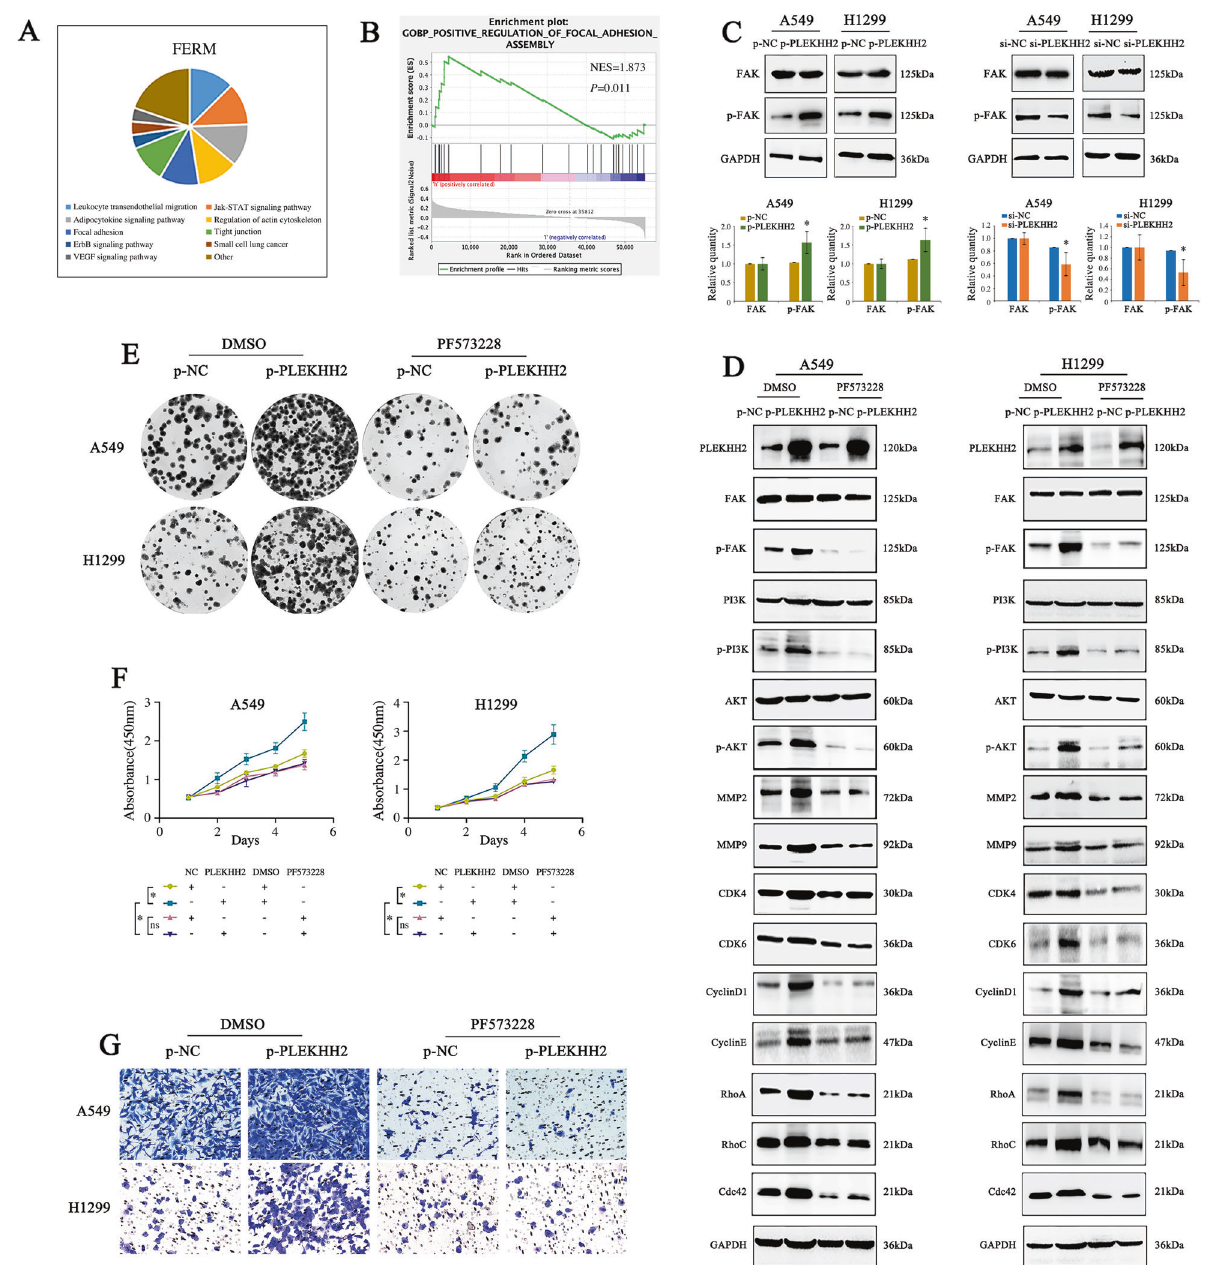
Fig. 5 PLEKHH2 activates the PI3K/AKT signaling pathway by promoting FAK phosphorylation. A The SMART database was used to analyze the cellular functions of proteins containing the FERM domain. B The GSEA database predicted that PLEKHH2 was enriched in focal adhesion assemblies. C Overexpression of PLEKHH2 promotes FAK phosphorylation, which plays an important role in the focal adhesion assembly process. PLEKHH2 knockdown decreased FAK phosphorylation, but the total protein level of FAK did not change signi fi